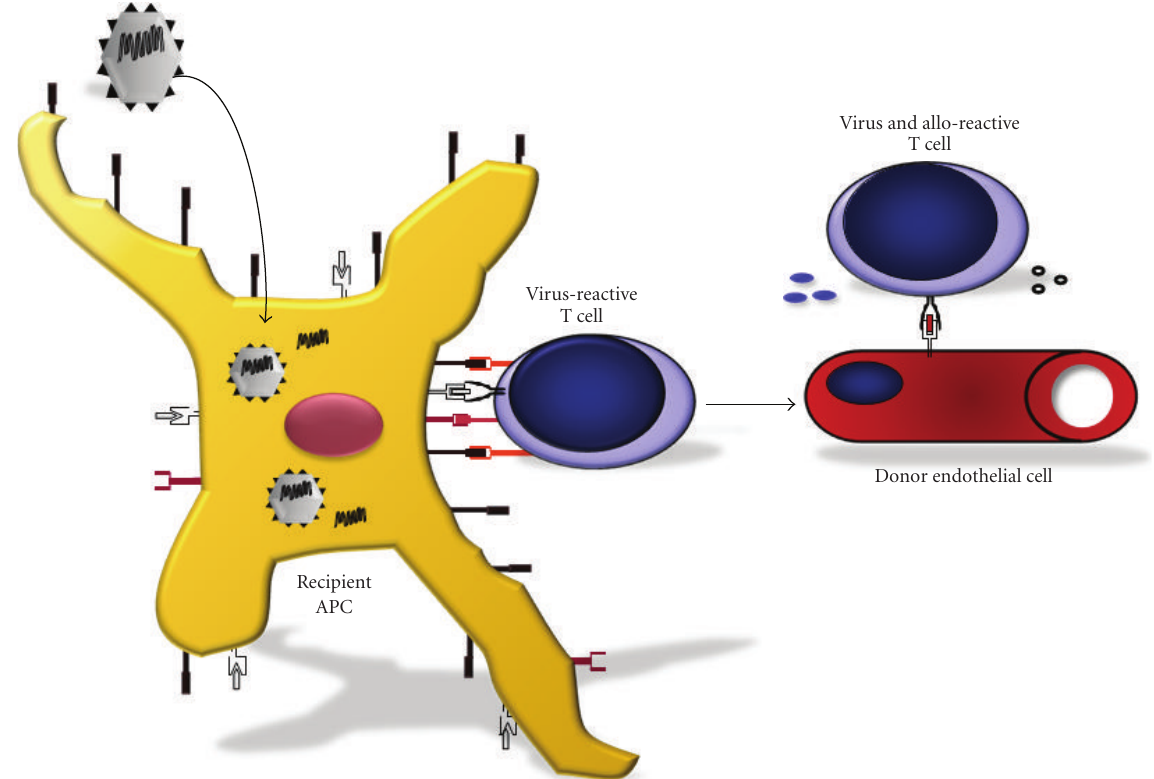
Figure 5: Heterologous immunity; cross-reactivity between viral and allogeneic antigens. Unlike the very small proportion of naive T cells that can respond to any given pathogen (reported to be ∼ 1:200 000), the frequency of T cells that directly recognize allogeneic antigens, such as MHC, is thought to be within 1:100–1:10. A proportion of those TCRs that recognize alloantigens, therefore, may have arisen as a result of virus infection that induces virus-specific T cells that cross-react with allo-MHC. Activation of these T cells may result in the recognition of MHC molecules found on donor tissues, such as the endothelium of transplanted organs, precipitating allograft